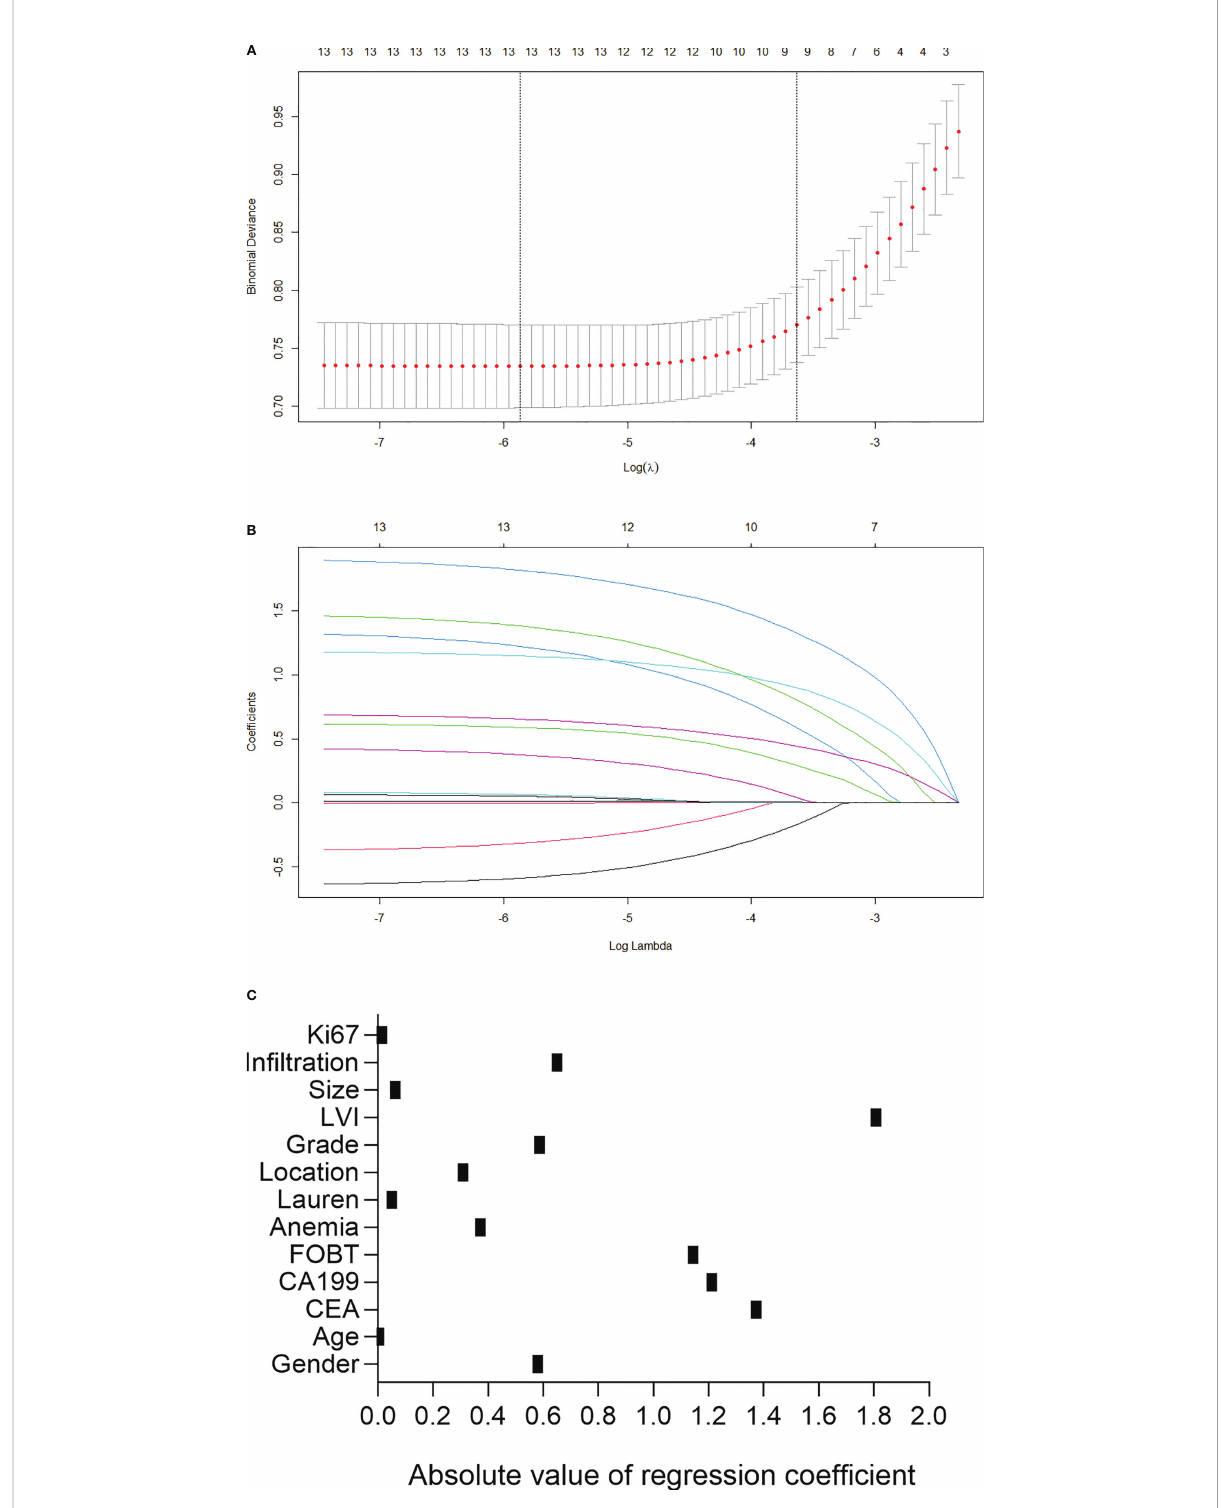
FIGURE 1 Predictor selection using the least absolute shrinkage and selection operator (LASSO) logistic regression model. (A) Identi fi cation of the optimal penalization coef fi cient lambda in the Lasso model using 10-fold cross-validation and the minimum criterion. (B) Lasso coef fi cient pro fi les of the 13 clinicopathological features. (C) Scatter diagram to show the absolute value of regression coef fi cient for each variable as calculated in LASSO logistic regression model. LVI, lymphovascular invasion; FOBT, fecal occult blood